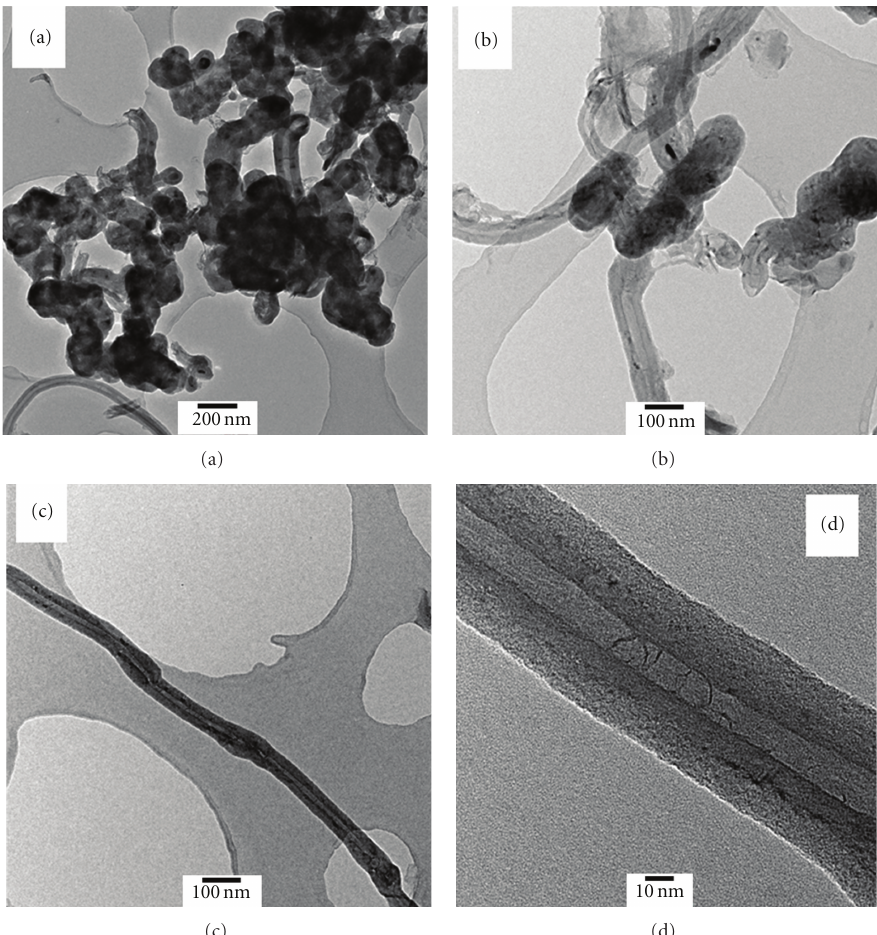
Figure 2: HR-TEM images of LiFePO 4 /CNT synthesised using the spray pyrolysis-modified CVD technique at (a) 9000x magnification, (b) 17000x magnification, (c) 17000x magnification, and (d) 130000x